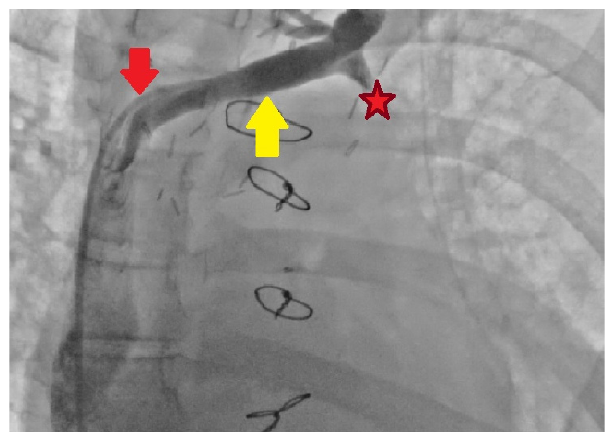
Fig. 3 - Postoperative cardiac catheterization. Yellow arrow=persistent left superior vena cava; red arrow=patent persistent left superior vena cava – right superior vena cava anastomosis; star=ligated stump of hemiazygos vein